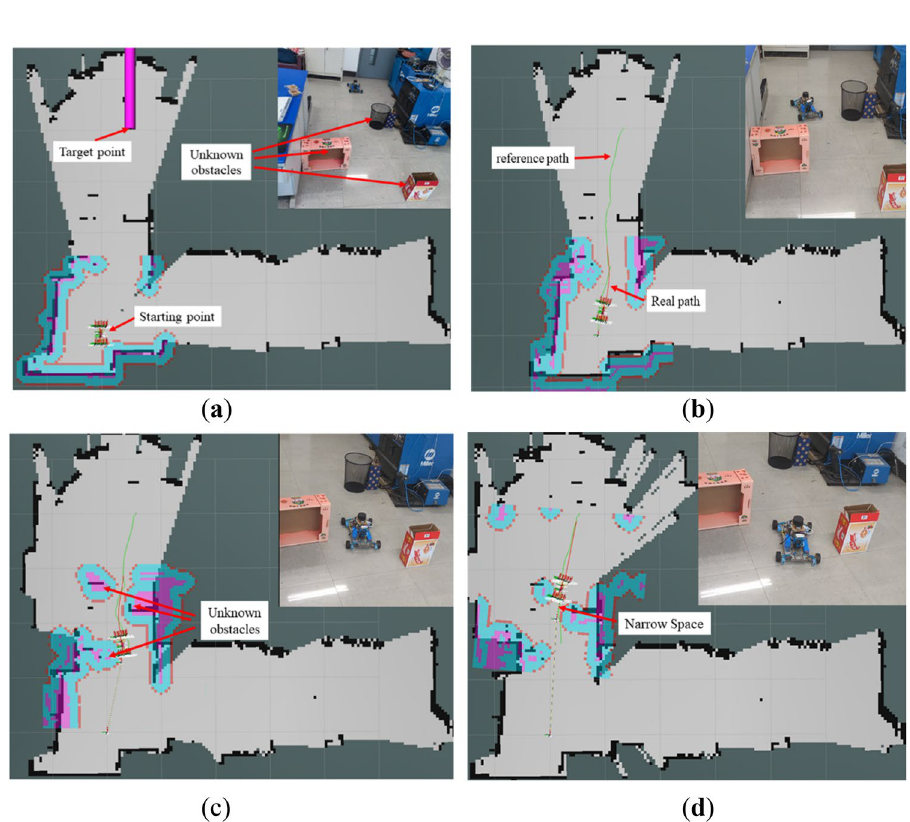
Figure 16. Movement of inspection robots avoiding unknown obstacles and passing through narrow spaces. ( a ) Position of robot and obstacles. ( b ) Robot dodging the first obstacle. ( c ) Detect the second obstacle and re-plan the path. ( d ) Robot passes through narrow space to reach the target